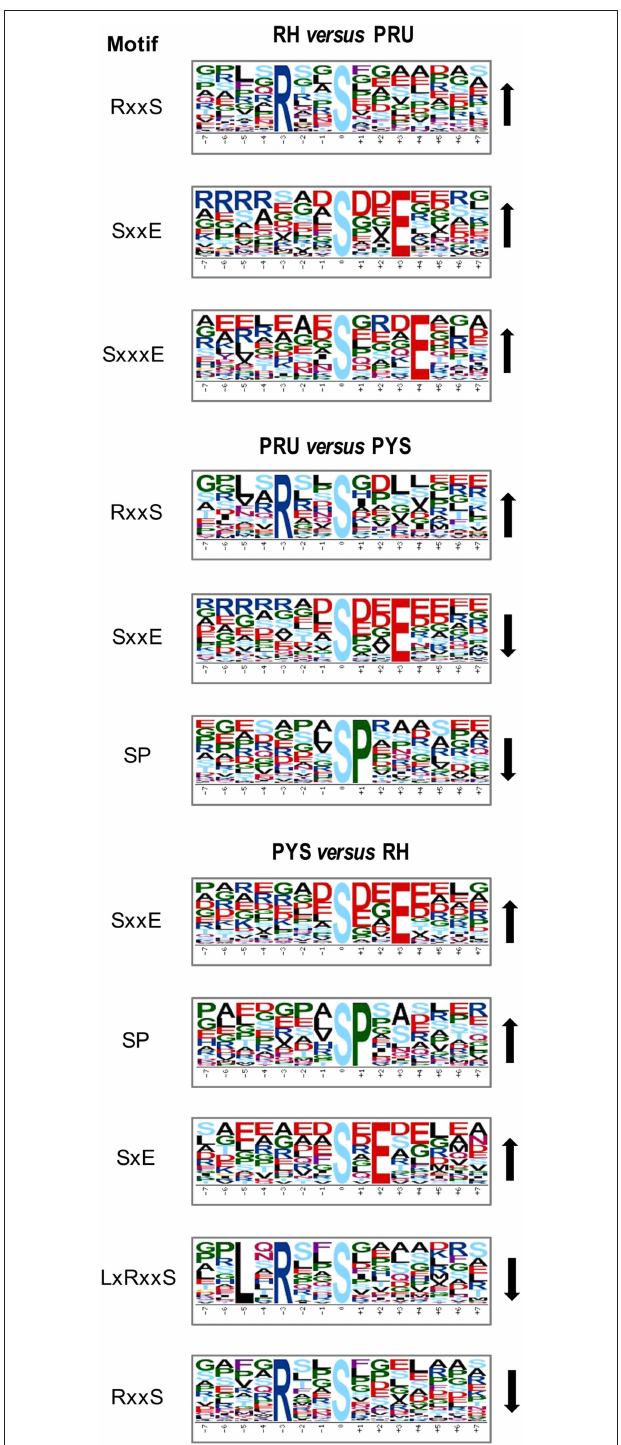
FIGURE 5 | Phosphorylation-specific motif analysis using the Motif-X algorithm. The representations of the serine phosphorylation motifs identified from all unambiguous phosphorylation sites are depicted as sequence logos. The height of the residues represents the frequency with which they occur at the respective positions. The color of the residues represents their physicochemical properties. Arrows pointing up or down on the right of each motif denotes that the motif was up-regulated or down-regulated, respectively.